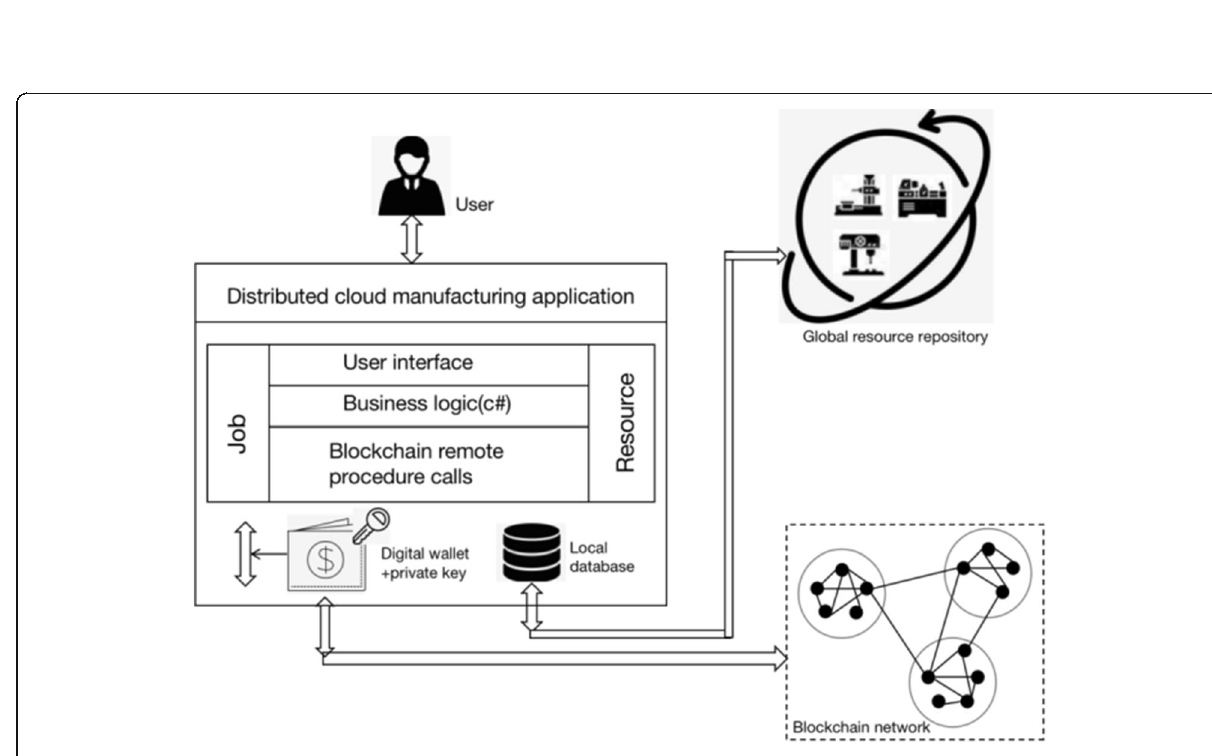
Fig. 7 Hybrid cloud manufacturing architecture extended version of